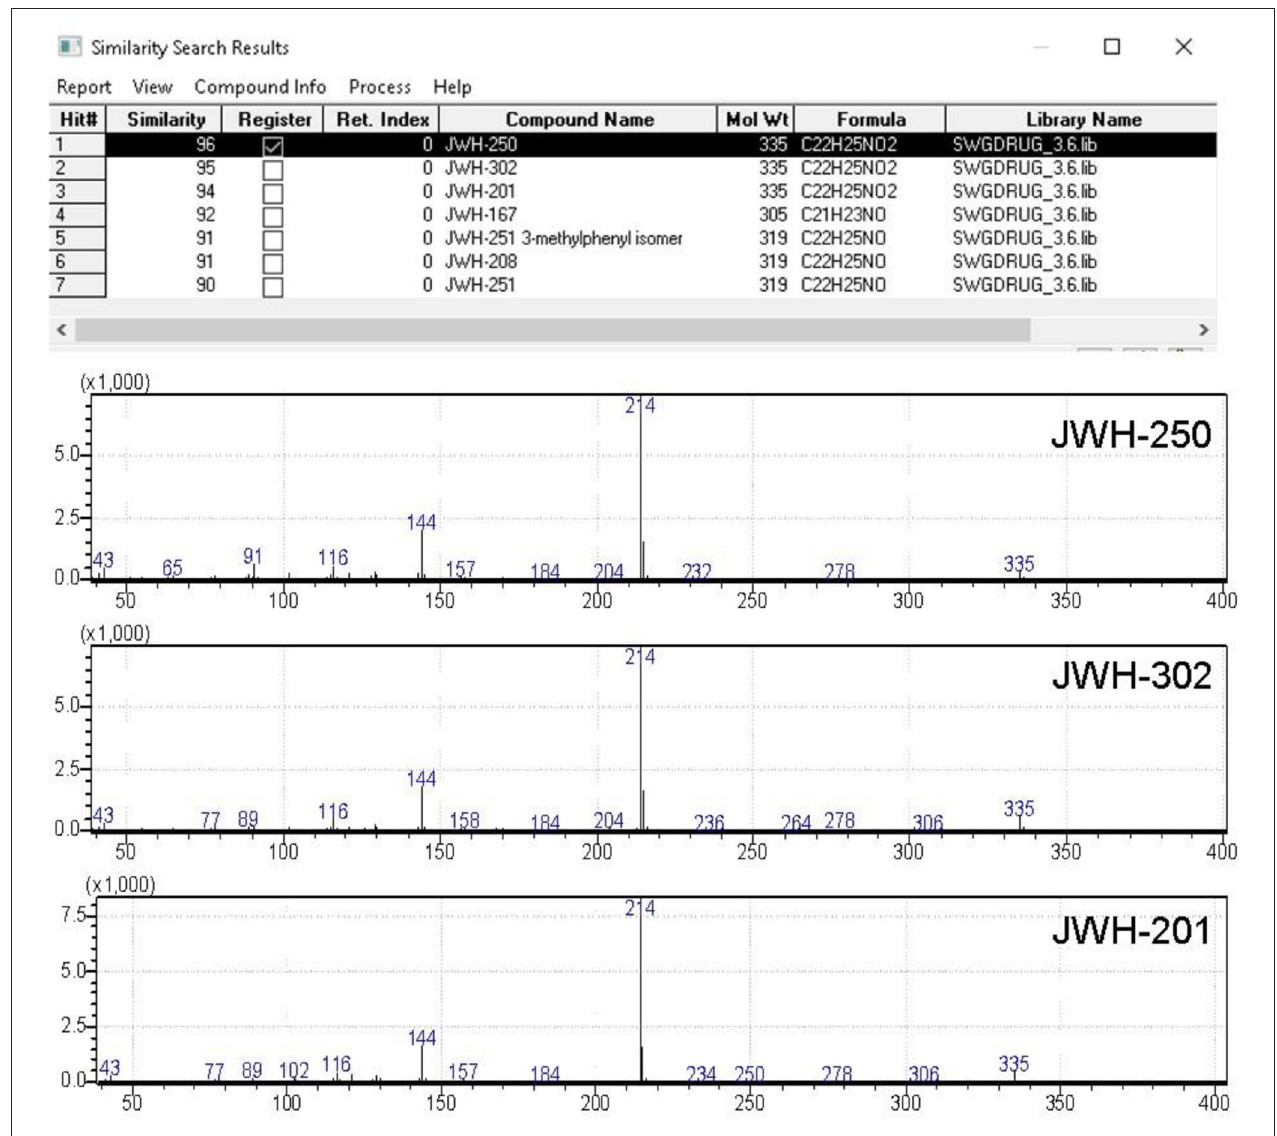
FIGURE 6 | Software window showing the library search results obtained for JWH-250 EI-MS spectral data. QMF obtained for against correct and incorrect matches are shown in column #2.